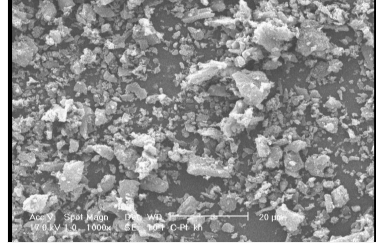
Figure 2. SEM of platinum nanoparticle loaded on activated carbon